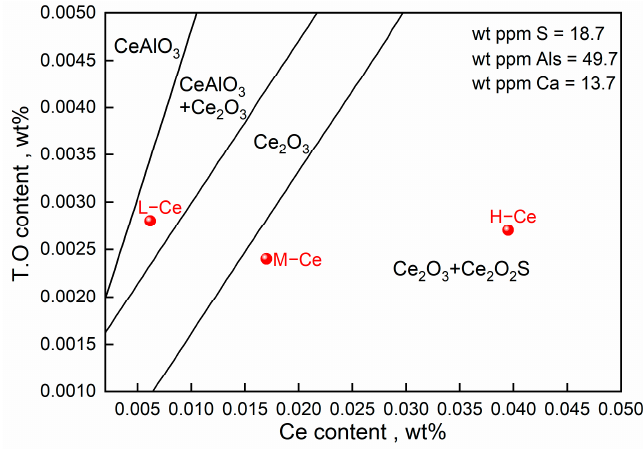
Figure 12. Stable phase diagram of Ce–Al–O–S inclusions in molten steel at 1600 °C.